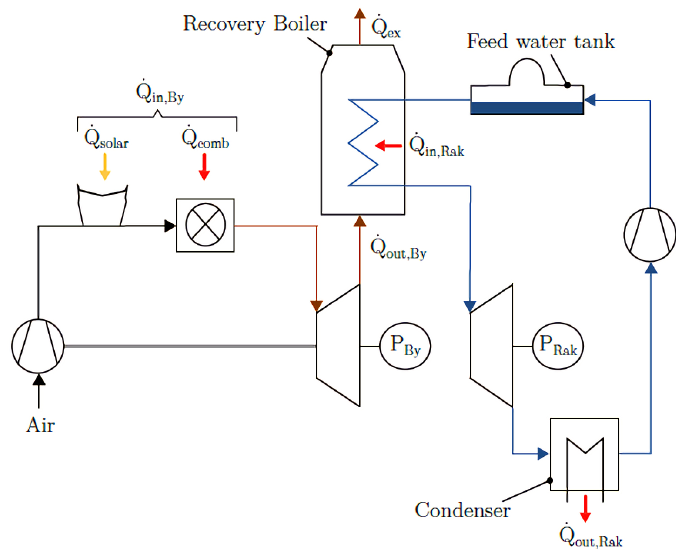
Figure 4. Scheme of the combined Brayton/Rankine cycle.